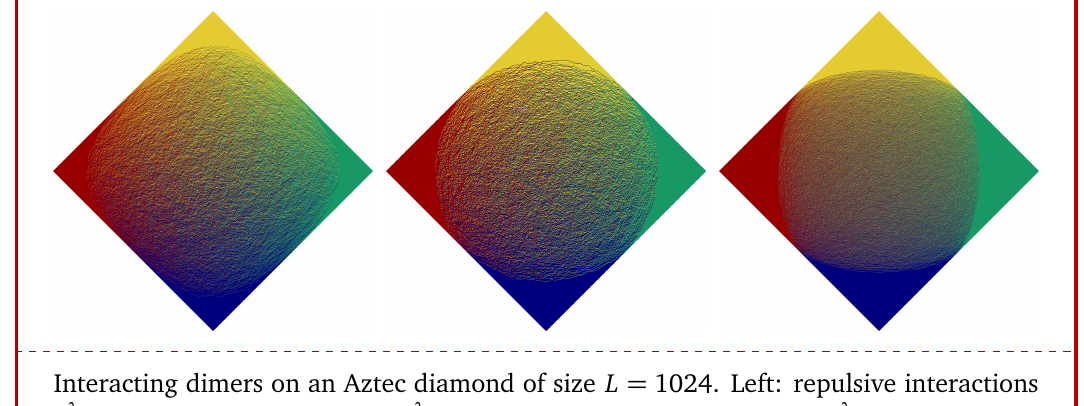
Interacting dimers on an Aztec diamond of size L = 1024. Left: repulsive interactions e λ = 0.4. Middle: free dimers e λ = 1. Right: attractive interactions e λ =